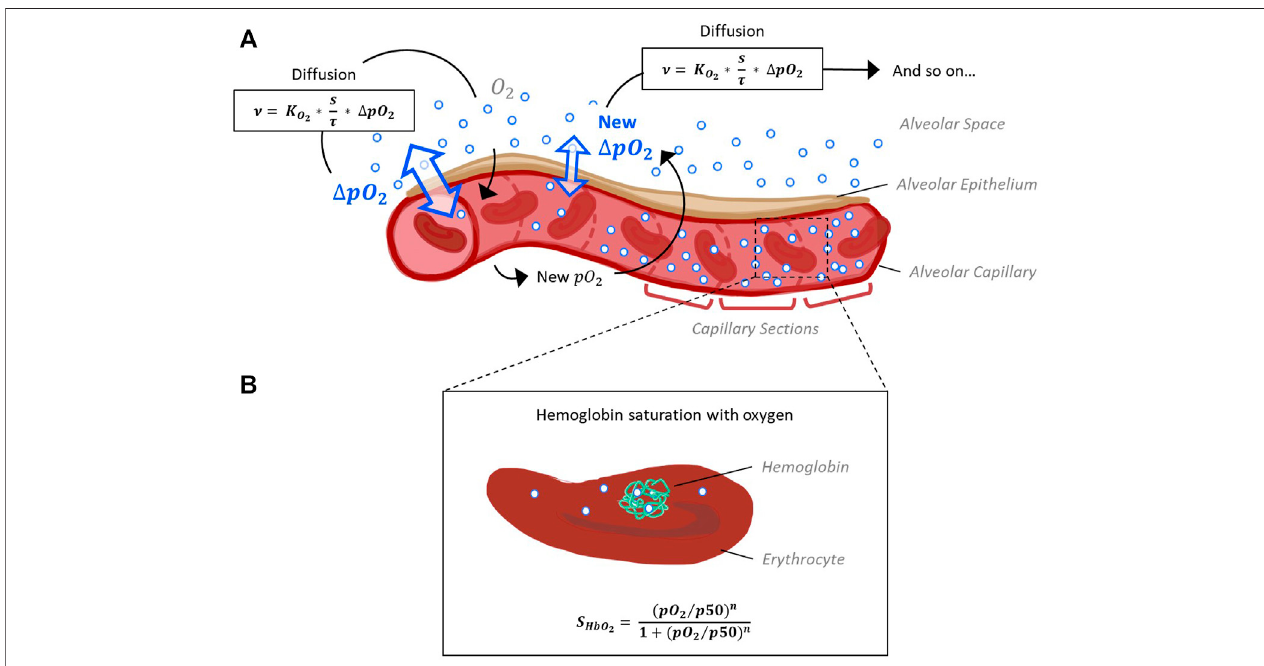
FIGURE1| Schematicrepresentationofthemodelcapillarywitherythrocytes,separatedfromalveolarspacebyasinglecelllayerofalveolarepithelium. (A) Inorder toreconstructO 2 andCO 2 pressuregradientsalongthecapillary,itisdividedintosectionsofequalsize.Thepressuregradientbetweenalveolarspaceandblood( Δ pO 2 ) and the resulting fl ow of oxygen along this gradient is calculated for each section subsequently, as oxygen fl ow into one section affects pO 2 and thus Δ pO 2 of the next section. Calculation of oxygen diffusion depending on Δ pO 2 is based on Fick ’ s law (Weibel et al., 1993). (B) According to the pO 2 and pCO 2 gradients along the capillarysectionsdetermined instep1,hemoglobinoxygensaturation(S HbO2 )iscalculatedforeachsection.ThecorrespondingHillequationhasbeende fi nedand fi tted to experimental data (Dash et al., 2016).